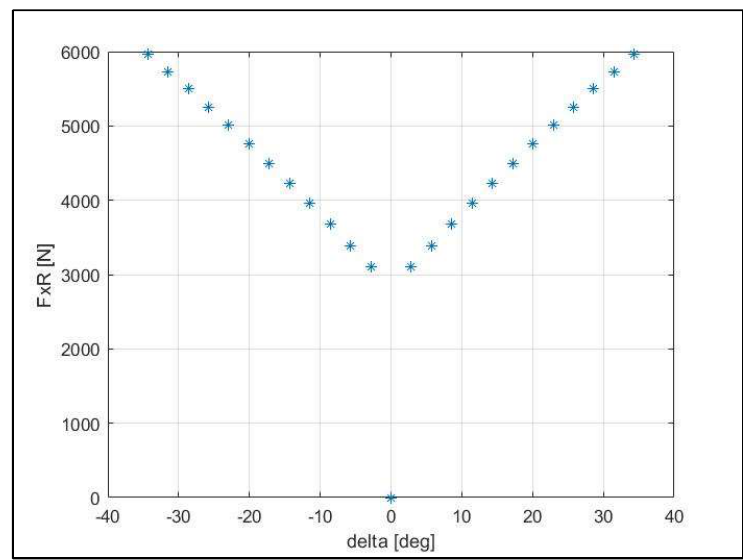
Figure 5. Equilibrium traction forces versus roadwheel angle.